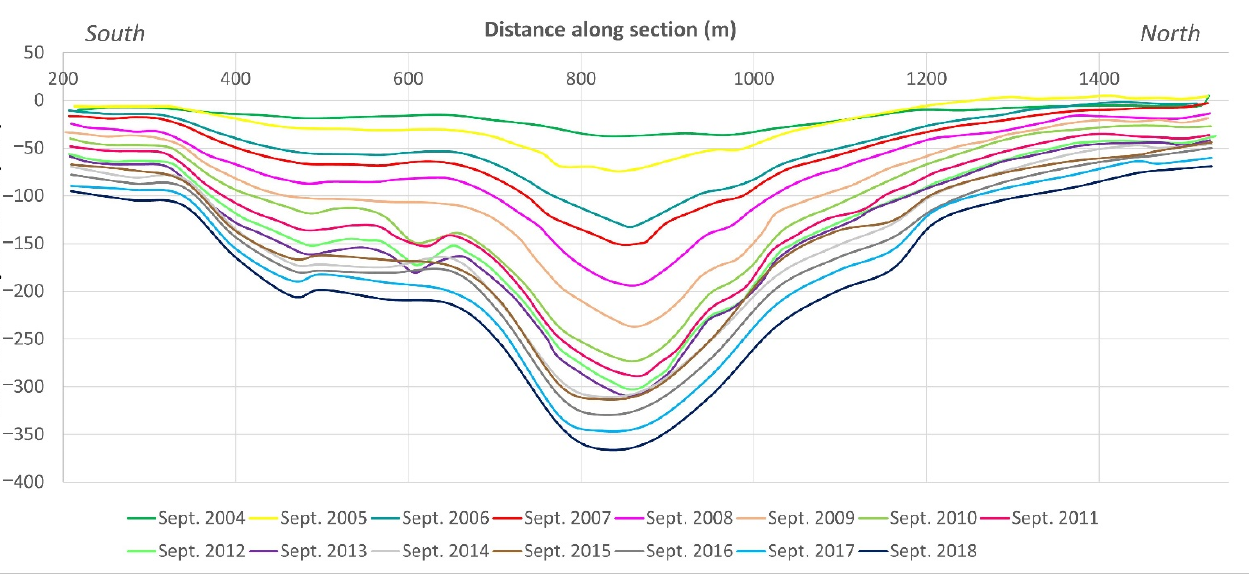
Figure 10. Longitudinal section of cumulative horizontal displacement along the eastern dam (Section 1, location in Figure 6a); curves from 2004 to 2013 are from [1]; curves from 2014 to 2018 are from AD-InSAR measurements.